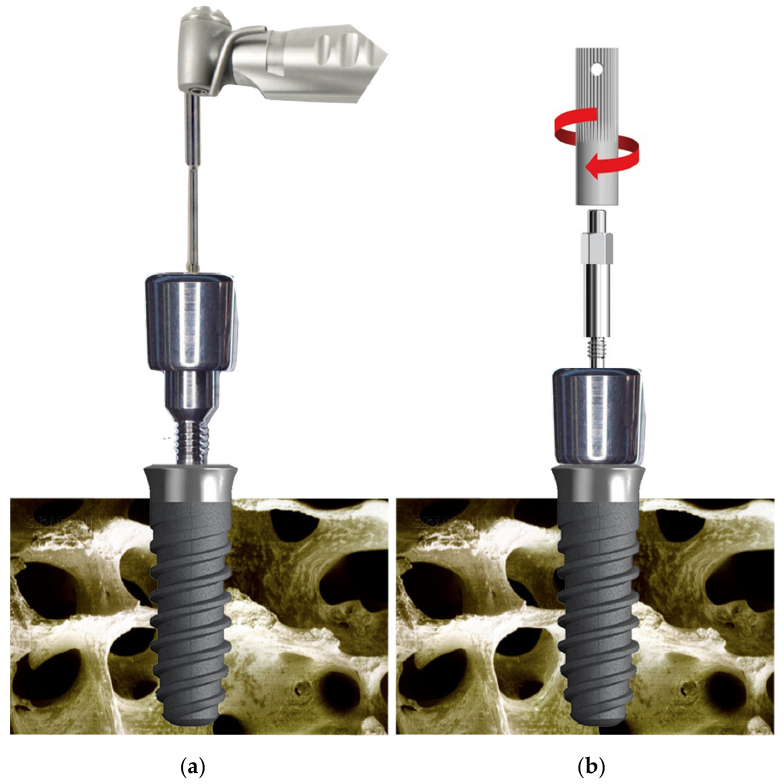
Figure 4. ( a ) Image of the healing cap placement method. ( b ) Manual placement of the SmartPeg with its plastic